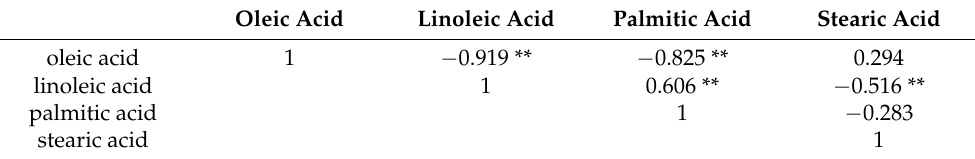
Table 4. Correlation of fatty acid composition (Pearson’s correlation coefficient). Oleic Acid Linoleic Acid Palmitic Acid Stearic Acid oleic acid 1 − 0.919 ** − 0.825 ** 0.294 linoleic acid 1 0.606 ** − 0.516 ** palmitic acid 1 − 0.283 stearic acid